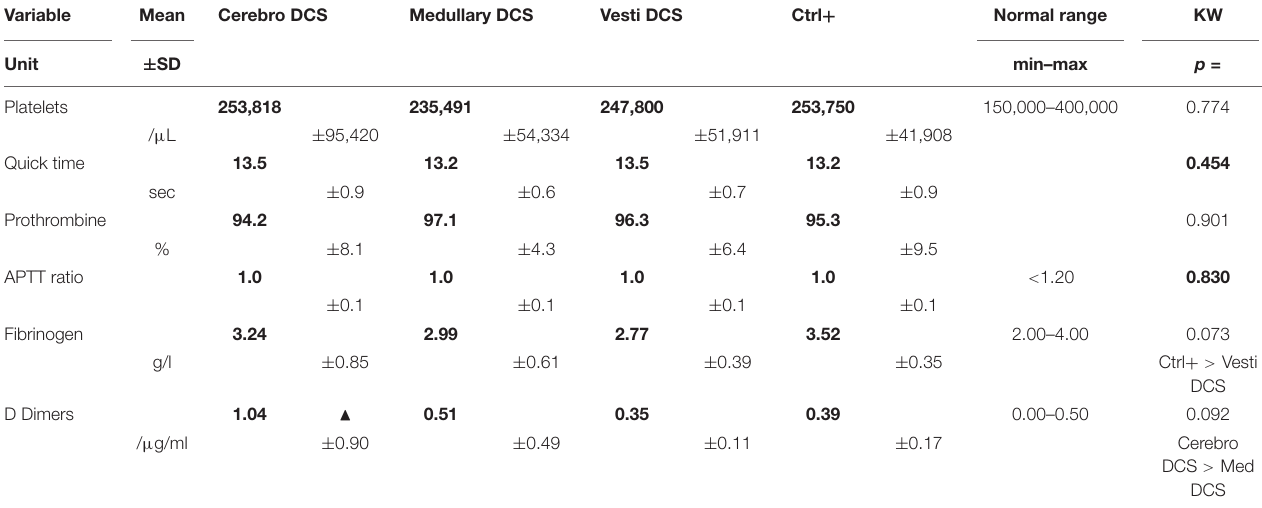
TABLE 3 | Major indices in